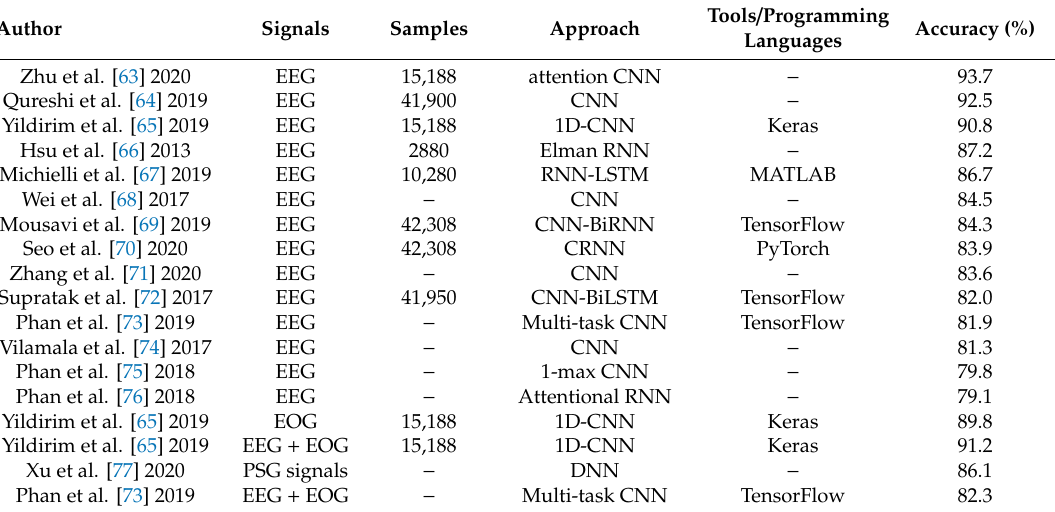
Figure 7. Pie chart representation of the frequency in which each sleep database was used in automated sleep stage classification studies. The total number of studies was 47, as listed in Tables 1–5. * Summary statistics: using various databases for sleep stage classification. Table 1. Summary of automated sleep stage classification approaches with DL applied to PSG recordings in Sleep-EDF